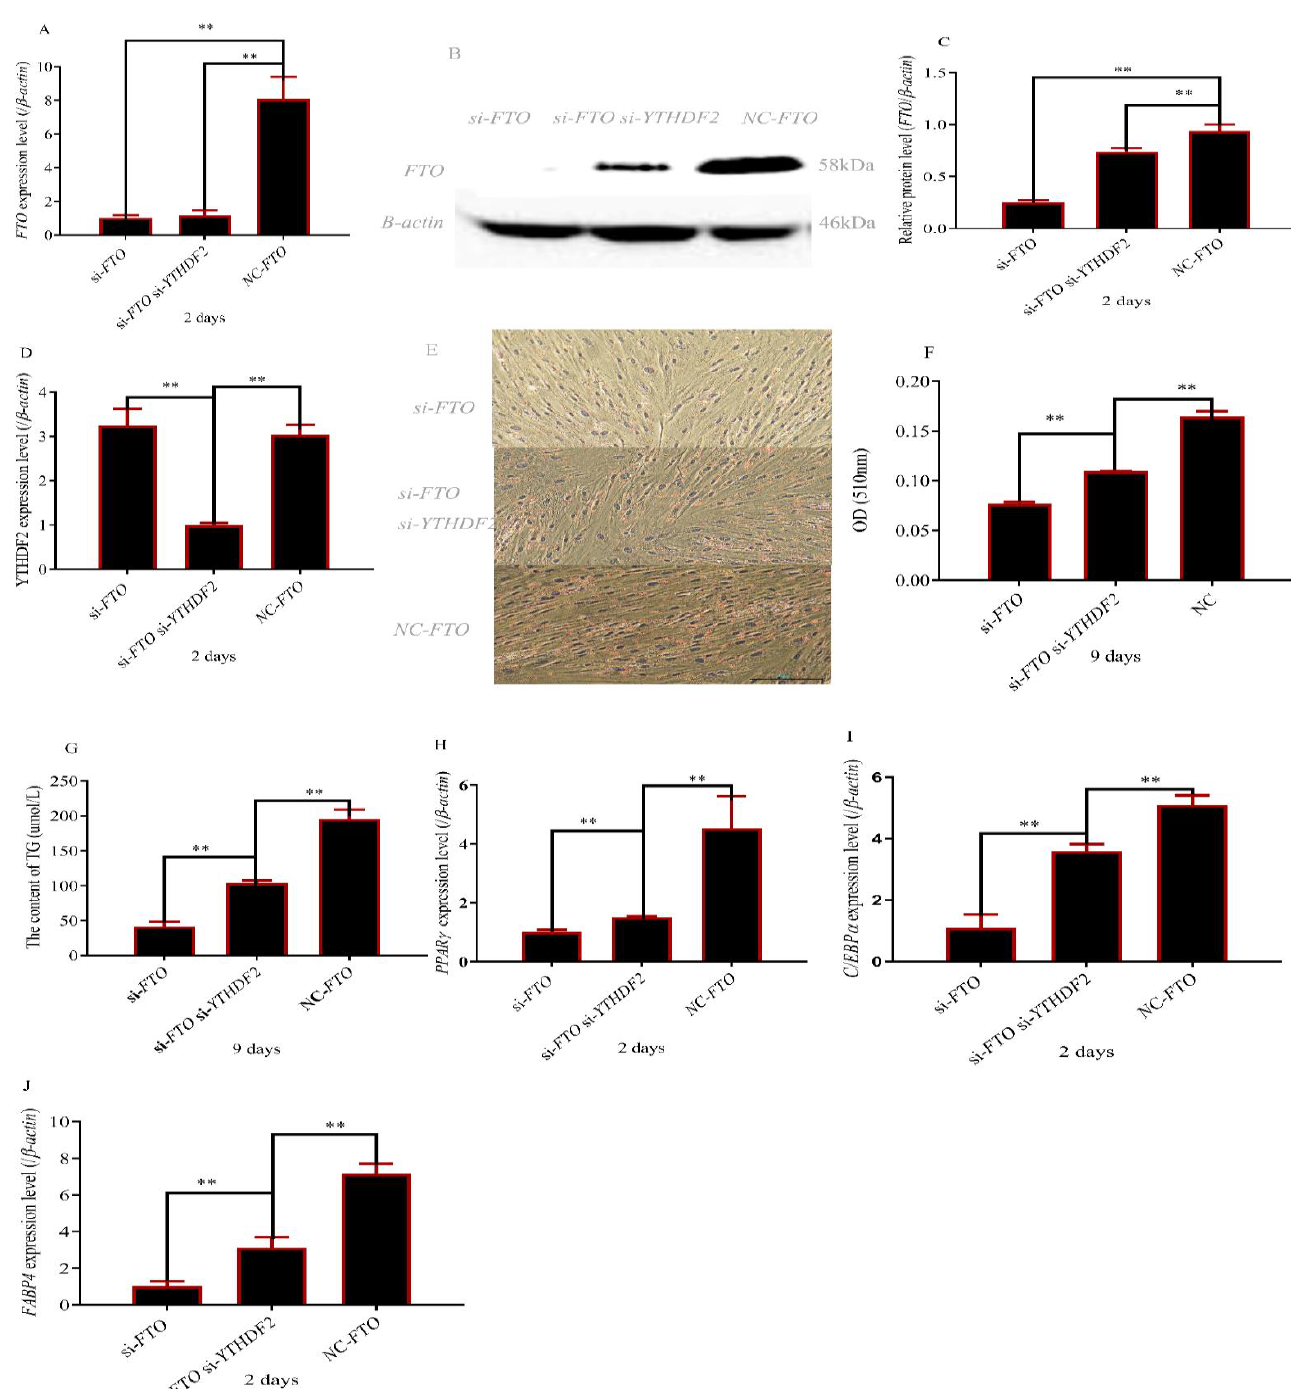
Figure 4. Inhibition of YTHDF2 reduced the inhibitory effect of interference FTO gene on rabbit preadipocyte differentiation. ( A ) FTO expression after transfecting with si-FTO , si-YTHDF2 and NC; ( B,C ) FTO protein level after transfecting with si-FTO , si-YTHDF2 and NC; ( D ) YTHDF2 expression after transfecting with si-FTO, si-YTHDF2 and NC; ( E ) size of lipid droplets (magnifications = 10 × 10); ( F ) content of lipid droplets; ( G ) Triglyceride content; ( H – J ) expression levels of PPARγ, CEBPα and FABP4 after transfecting with si-FTO , si-YTHDF2 and NC; ( ** p ≤ 0.01 ).